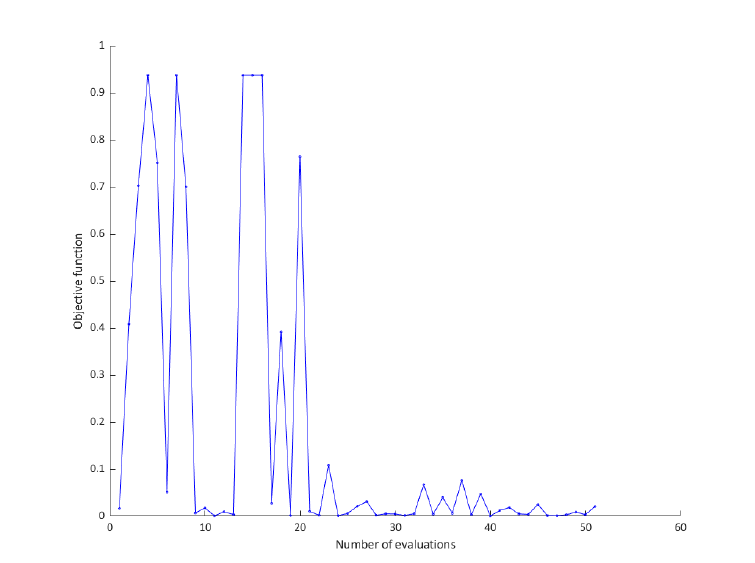
Figure 6. Objective function